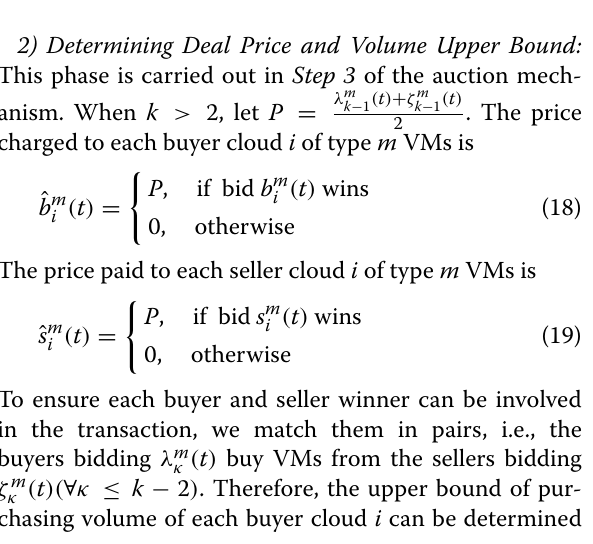
Fig. 4 The quantity of jobs with respect to number of VM and execution time